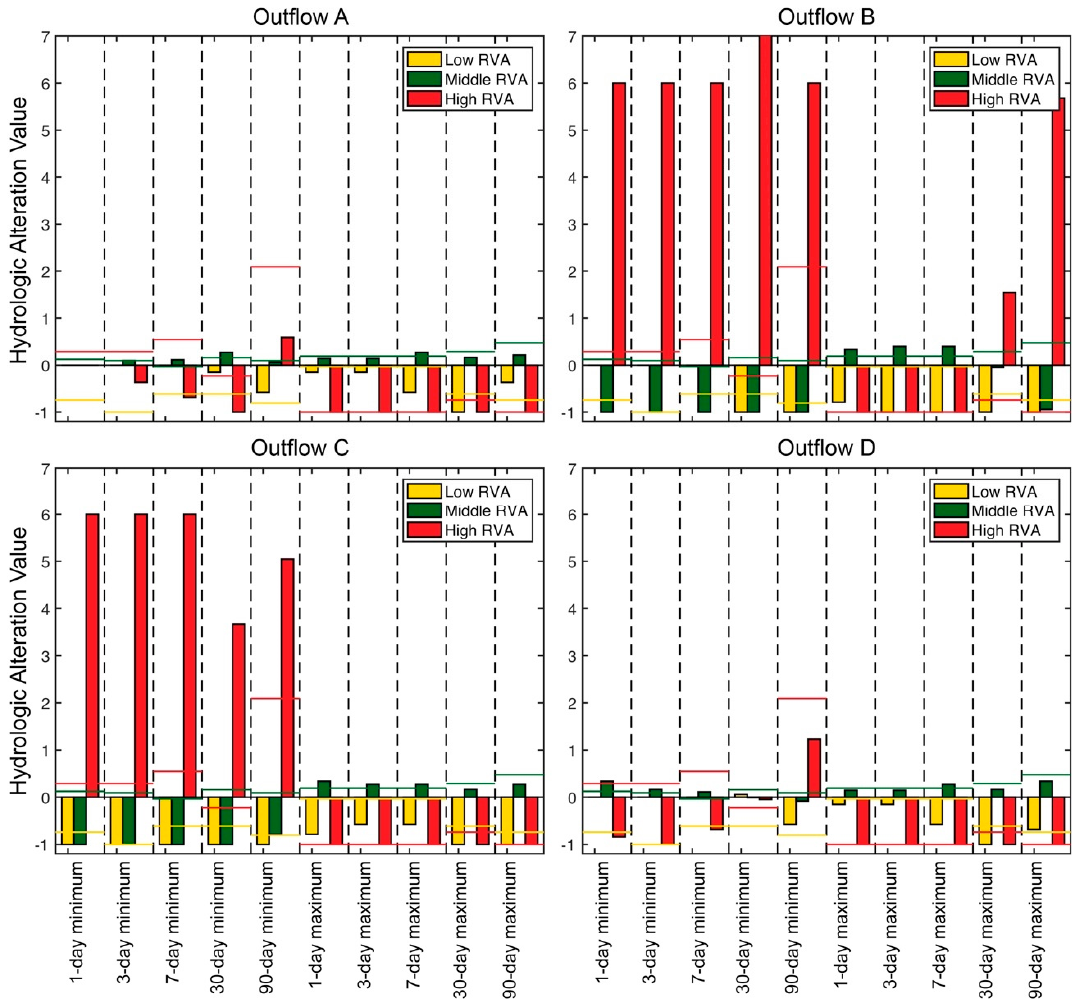
Figure 5. Hydrologic alteration values calculated from Hydrologic Engineering Center Hydrologic Modeling System (HEC-HMS) outputs for subcatchments spanning a range of urbanization change. Colored horizontal lines indicate the hydrologic alteration values for the watershed outlet.